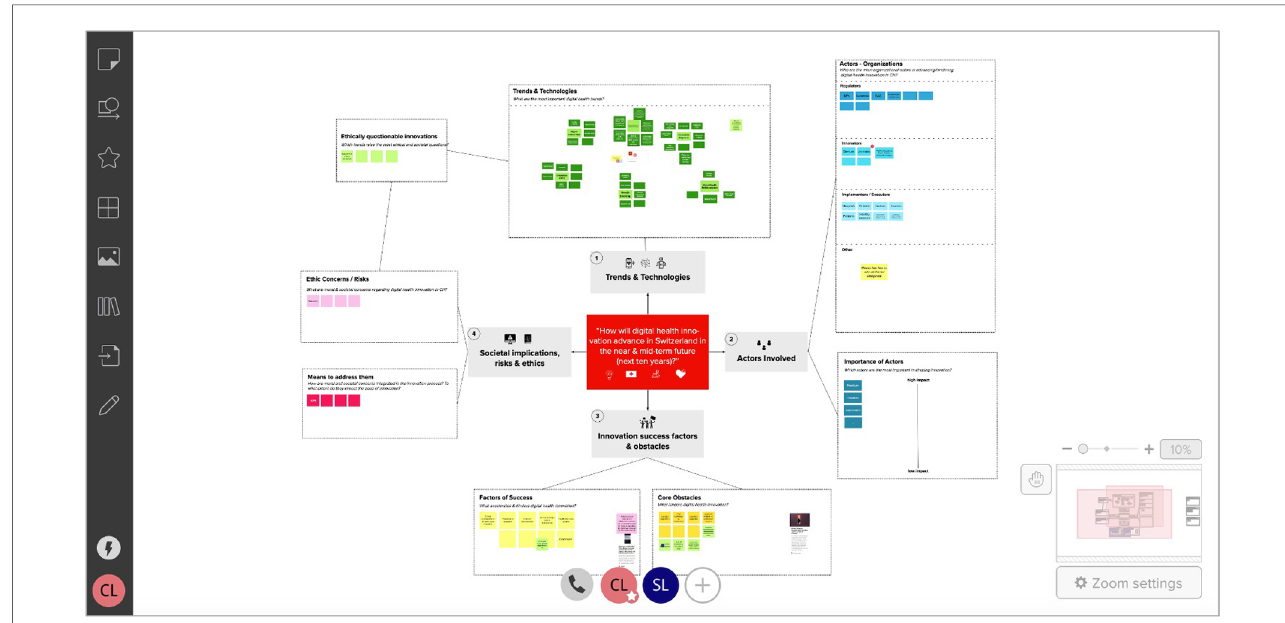
FIGURE 2 MURAL Map during fi rst participant interaction. Note: This screenshot was taken during the fi rst participant ’ s ( “ SL ” ) editing of the MURAL mind-map. The interface shown is the MURAL platform. The canvas shown already contains some of the participant ’ s contributions. The “ original ” canvas looked almost identical, but did not contain stickers in the tends & technology section, one sticker each in the actor subsections (i.e., regulators, innovators), and only two stickers each in the “ Factors of Success ” , “ Core obstacles ”